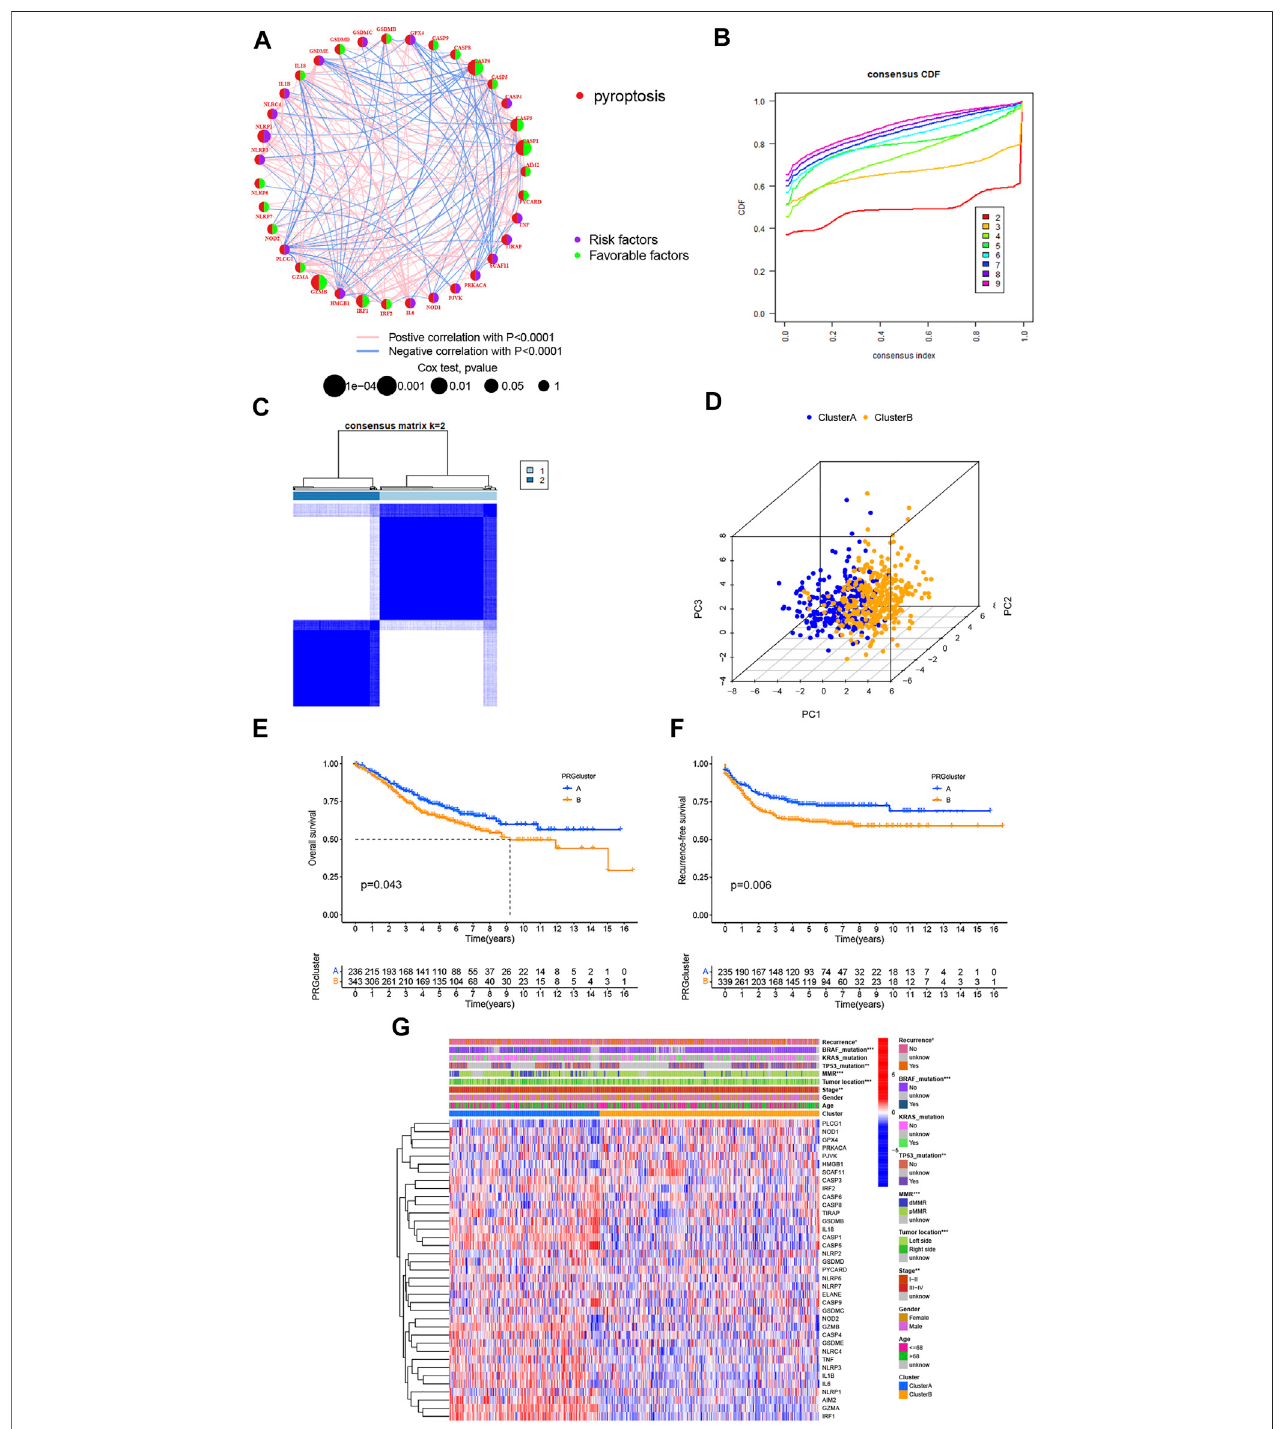
FIGURE 2 | Two distinct subtypes of CRC are related by 37 PRGs based on consistent clustering. (A) Univariate cox regression analysis of OS for each PRGs in GSE39582cohorts. (B,C) Consensusmatrixheatmapde fi ningtwoclusters(k=2)andtheircorrelationarea. (D) PCAshowedaremarkabledifferenceintranscriptomes betweenthetwosubtypes,respectively. (E,F) OSandRFScurvesshowing37PRGsforthetwodistinctsubtypes,respectively. (G) Differencesinclinicopathologicaland biological characteristics of two distinct subtypes. * p < 0.05; ** p < 0.01; and *** p < 0.001.